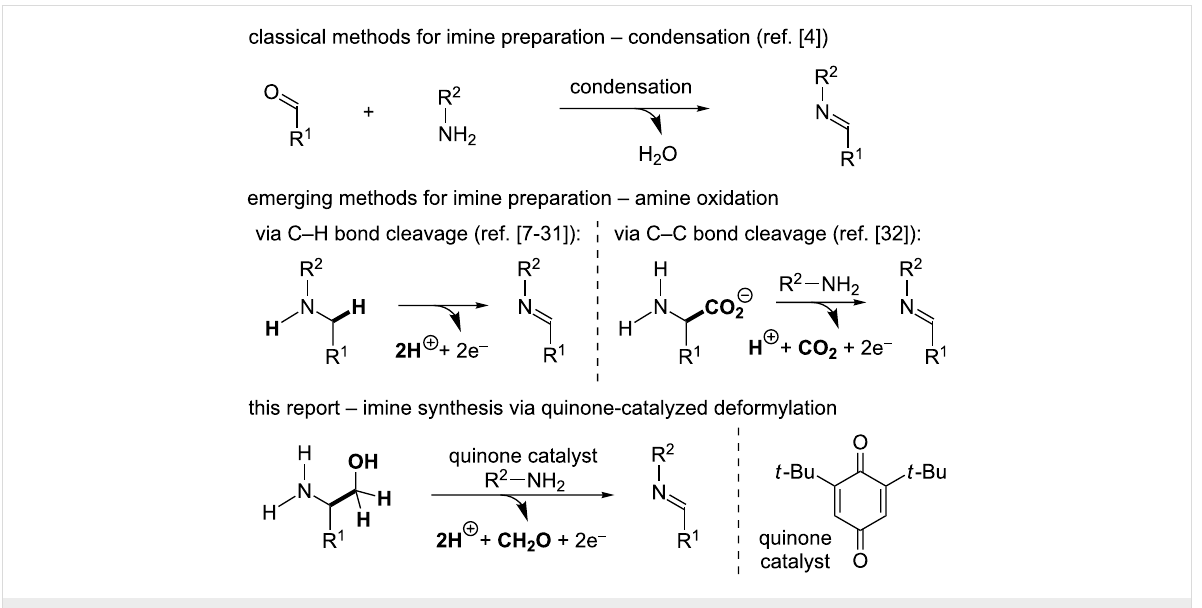
Scheme 1: Established methods for the preparation of imines vs this work.